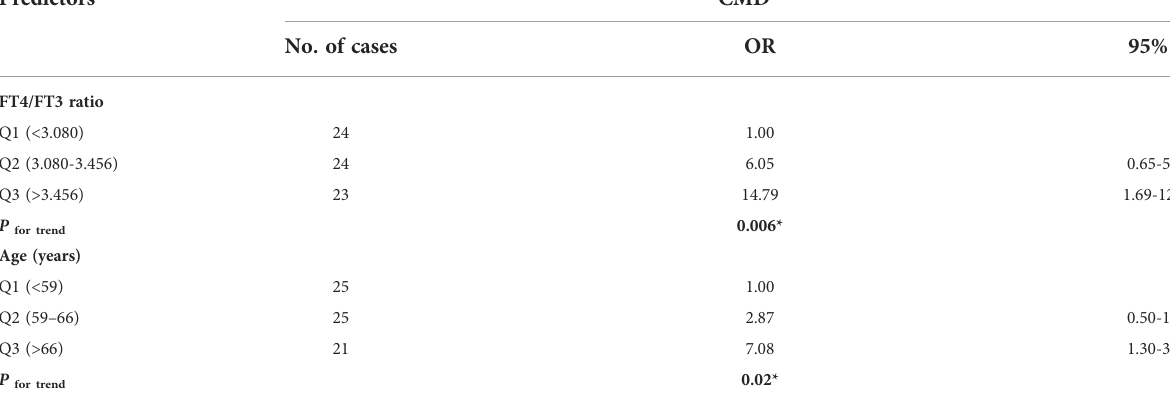
TABLE 4 Logistic regression analysis for predicting CMD according to trisection of predictors.